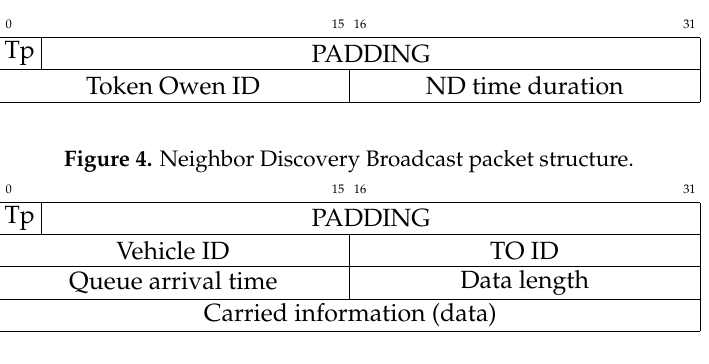
Figure 5. Neighbor Discovery Response packet